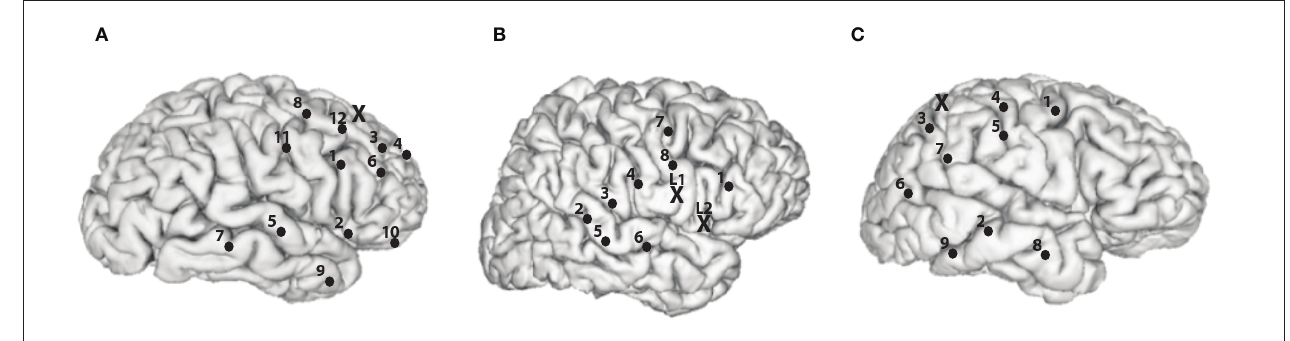
FIGURE 1 | Recording and stimulation electrode placements for the subjects. Black dots represents recording channels while black “X” represents stimulating channel(s). (A) Subject A, right hemisphere is shown. 1, Inferior frontal opercular; 2, anterior horizontal lateral fissure; 3, middle frontal gyrus; 4, middle frontal sulcus; 5, superior temporal sulcus; 6, inferior frontal sulcus; 7, middle temporal gyrus; 8, middle frontal gyrus; 9, middle temporal gyrus; 10, orbital gyrus; 11, precentral gyrus; 12, superior frontal sulcus; and X, middle frontal gyrus. (B) Subject B, right hemisphere is shown.